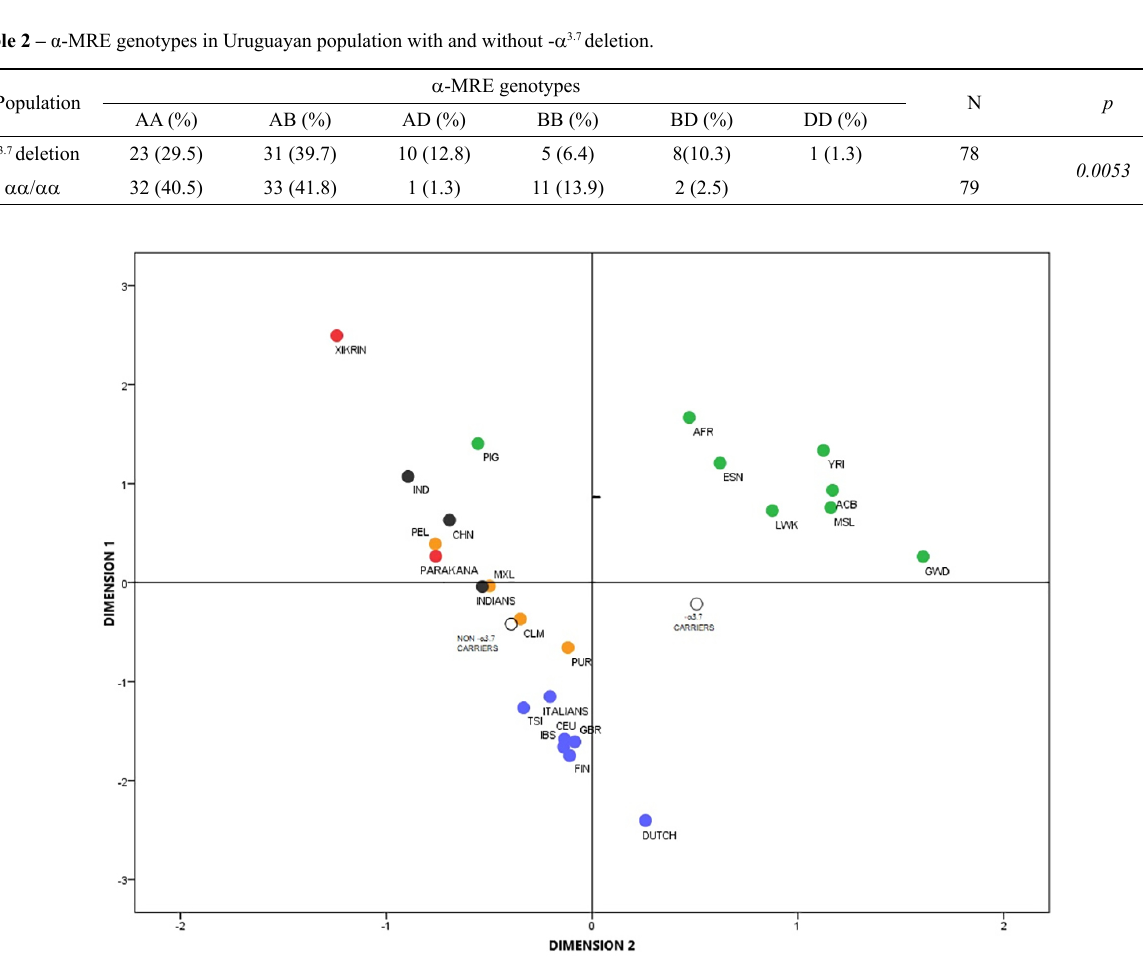
genetic distances calculated from alpha-MRE genotypes. Figure 1 – Multidimensional scaling (MDS) based on pairwise F ST Stress: 0.01390; RSQ: 0.99913. -α3.7 CARRIERS & NON -α3.7 CARRIERS: Uruguayan populations. Green: African and African derived populations. YRI: Yoruba in Ibadan, Nigeria. ACB: African Caribbeans in Barbados. GWD: Gambian in Western Divisions in the Gambia. MSL: Mende in Sierra Leone. ESN: Esan in Nigeria. LWK: Luhya in Webuye, Kenya. AFR: Bantu-speaking Africans. PIG: Pygmies from the Central African Republic. Orange: Admixed Latin-American populations. PEL: Peruvians from Lima, Peru. PUR: Puerto Ricans from Puerto Rico. CLM: Colombians from Medellin, Colombia. MXL: Mexican Ancestry from Los Angeles USA. Blue: European populations. IBS: Iberian Population in Spain. TSI: Toscani in Italia. CEU: Northern and Western European Ancestry. FIN: Finnish in Finland. ITALIANS. DUTCH. GBR: British in England and Scotland. Black: Asian populations. IND: Indonesians from Java. CHN: Southern Chinese. INDIANS: Andra-Pradesh, India. (1000genomes; Harteveld et al ., 2002; Ribeiro et al .,